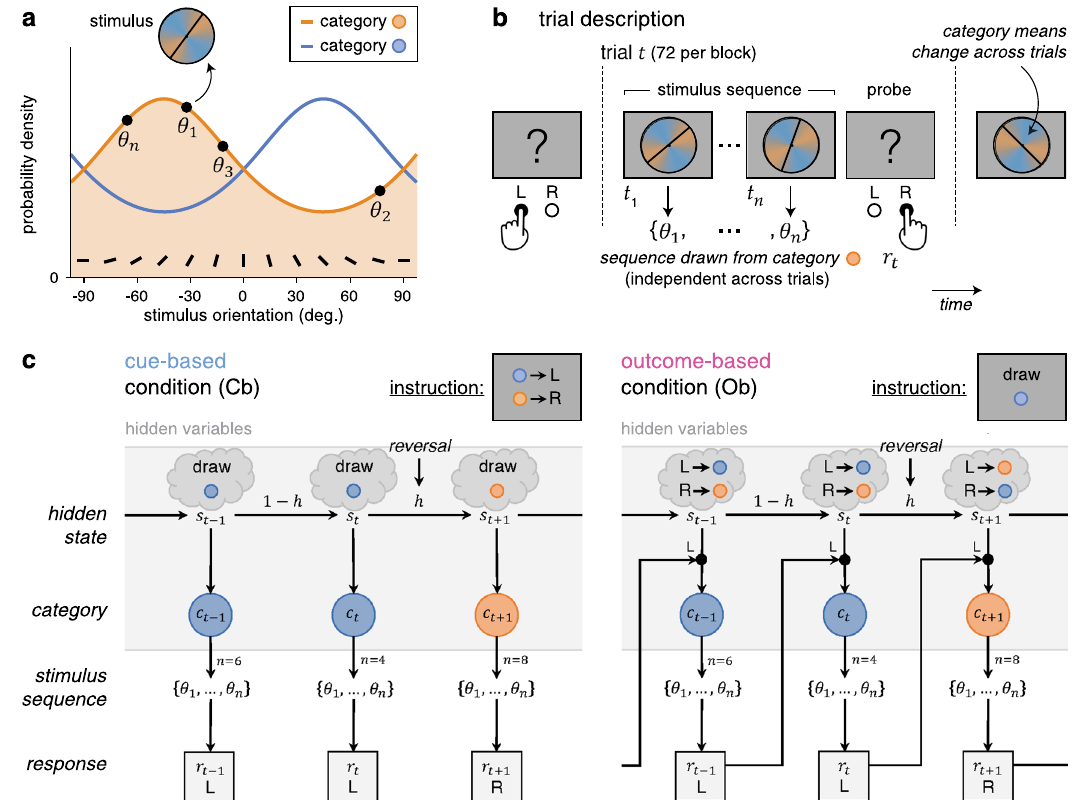
Fig. 1 Reversal learning task and conditions. a Generative stimulus distributions used for the two categories A and B. Stimuli correspond to bars of (cid:4) (cid:5) orientations θ 1 ; ¼ ; θ n drawn from one of two color-labeled categories, associated with overlapping probability density functions centered on orthogonal (cid:4) (cid:5) orientations. b Trial description. Each trial t consists of a sequence of two to eight stimuli θ 1 ; ¼ ; θ n drawn from one of the two categories, presented at an average rate of 2 Hz, after which participants provide a response r t (the left or right key press) regarding the hidden state of the task being tracked. c Graphical description of cue-based and outcome-based conditions. Left: in the cue-based (Cb) condition, participants are instructed to monitor the deck (category A or B) from which presented cards (oriented stimuli) are drawn. This hidden state s t of the task alternates occasionally and unpredictably between trials. In this example, the hidden state s t reverses at the end of trial t . Right: in the outcome-based (Ob) condition, the same participants